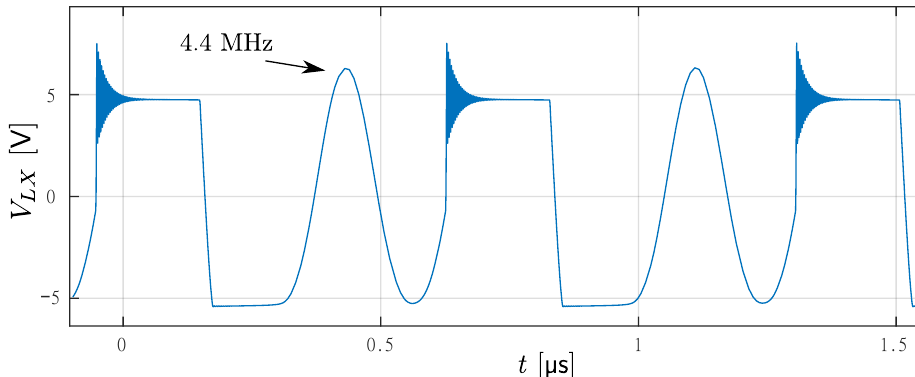
Figure 7. Measured oscillation during discontinuous current conduction mode.